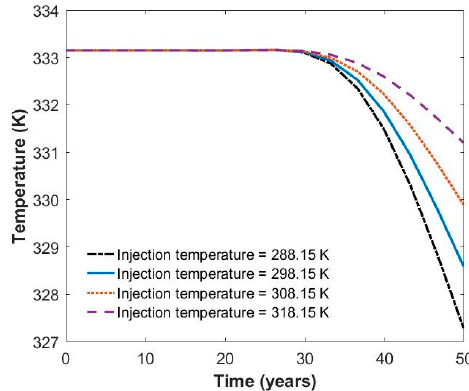
Figure 7. Time evolution of production well in reinjection temperature studies.